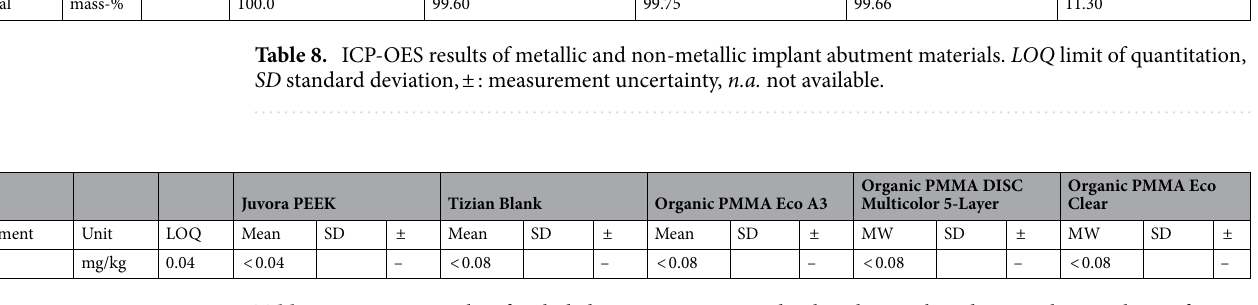
Table 9. ICP-OES results of included PEEK-, PMMA- and polycarbonate-based materials. LOQ limit of quantitation, SD standard deviation, ± : measurement